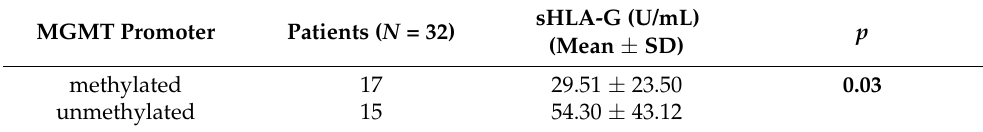
Table 6. Plasma levels of sHLA-G in glioma patients with different MGMT promoter methylation statuses.